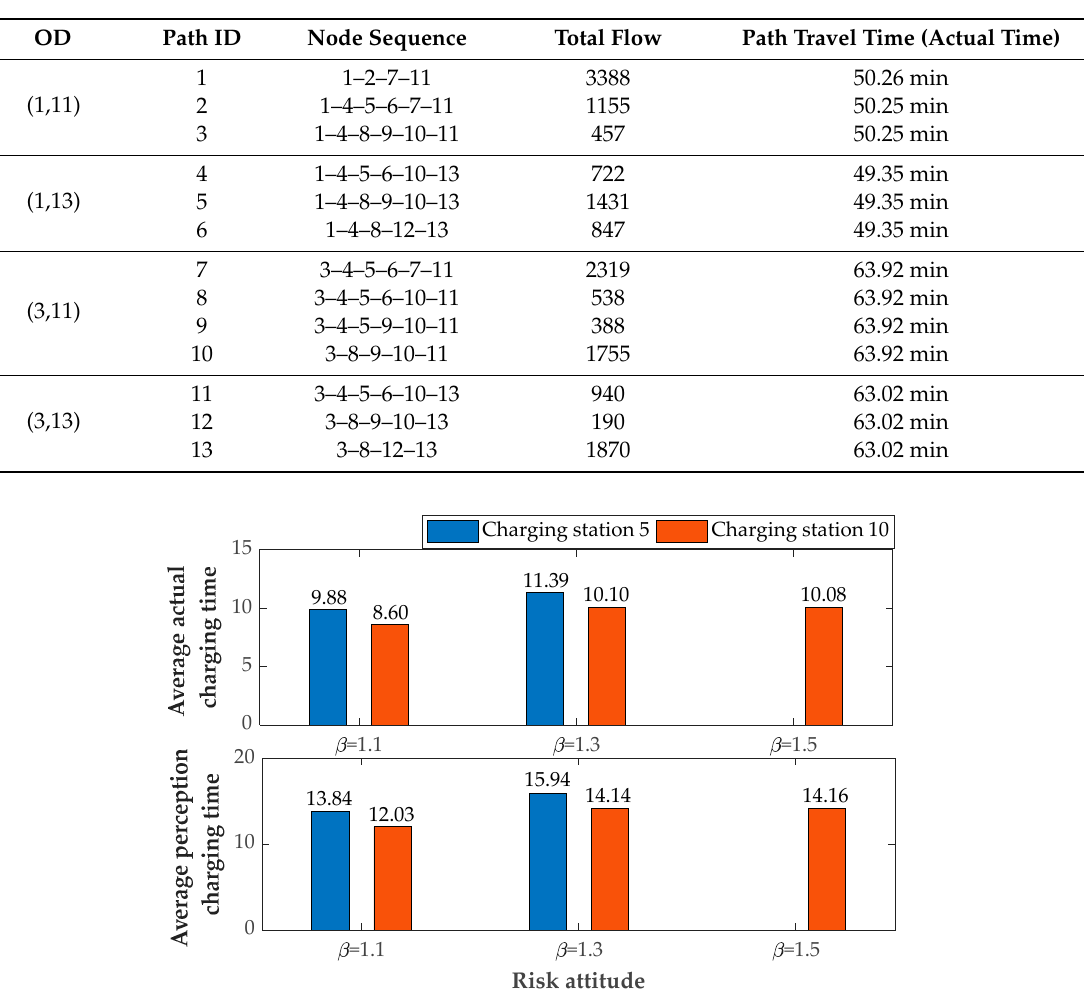
Table 5. Path flow and path travel time under the equilibrium (without the battery safety margin).